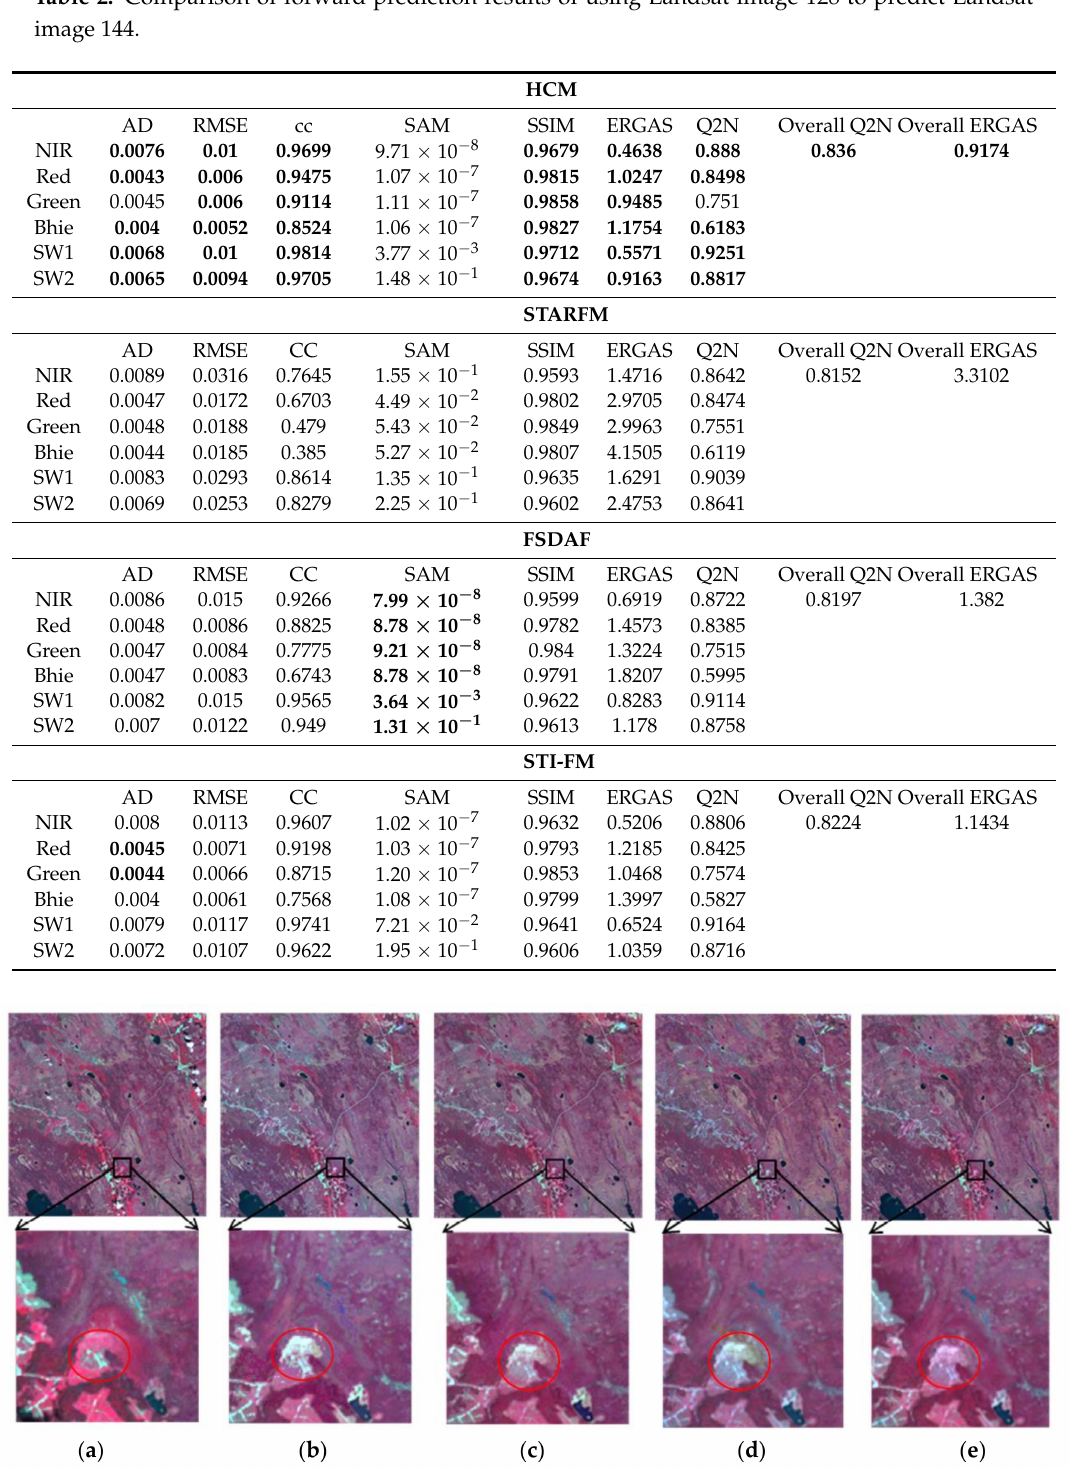
Figure 5. Comparison of forward prediction results of using Landsat image 144 to predict Landsat image 192. ( a ) Actual image; ( b ) STARFM; ( c ) FSDAF; ( d ) STI-FM; ( e )